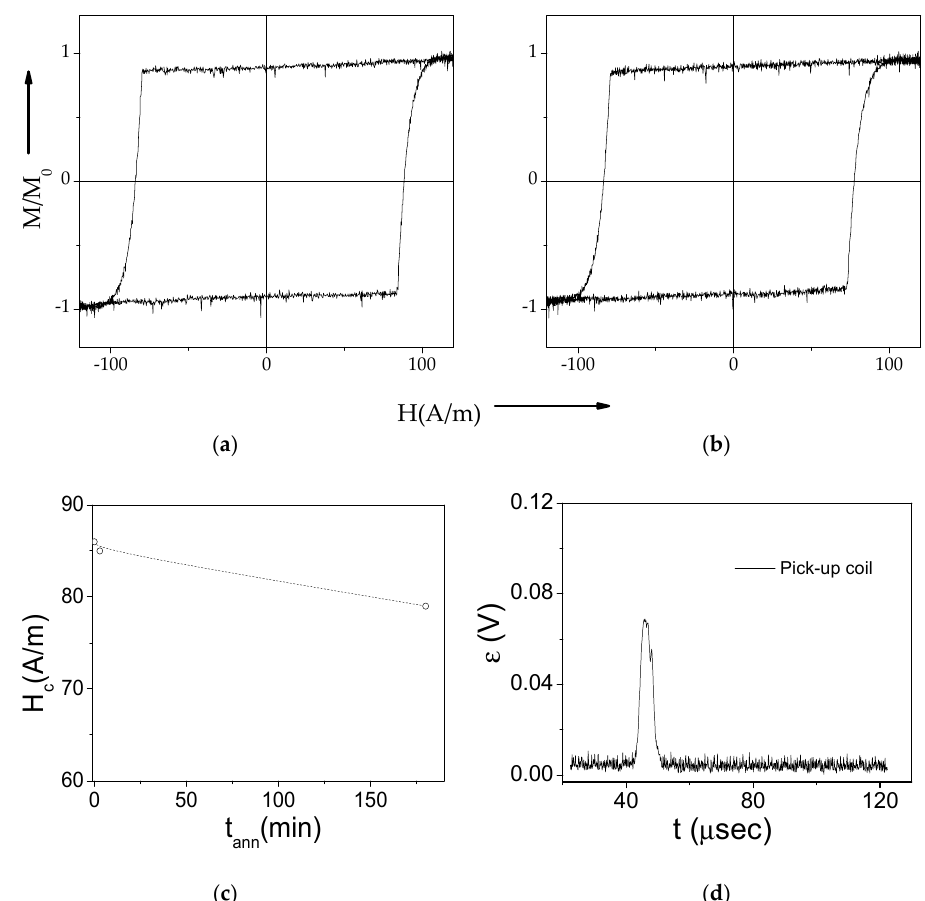
Figure 3. Hysteresis loops of as-prepared ( a ) and annealed at T ann = 400 °C for 180 min ( b ) Fe 75 B 9 Si 12 C 4 microwires; dependence of coercivity on annealing time ( c ) and the time dependence of the EMF signal in the pick-up coil of as-prepared Fe 75 B 9 Si 12 C 4 microwire ( d